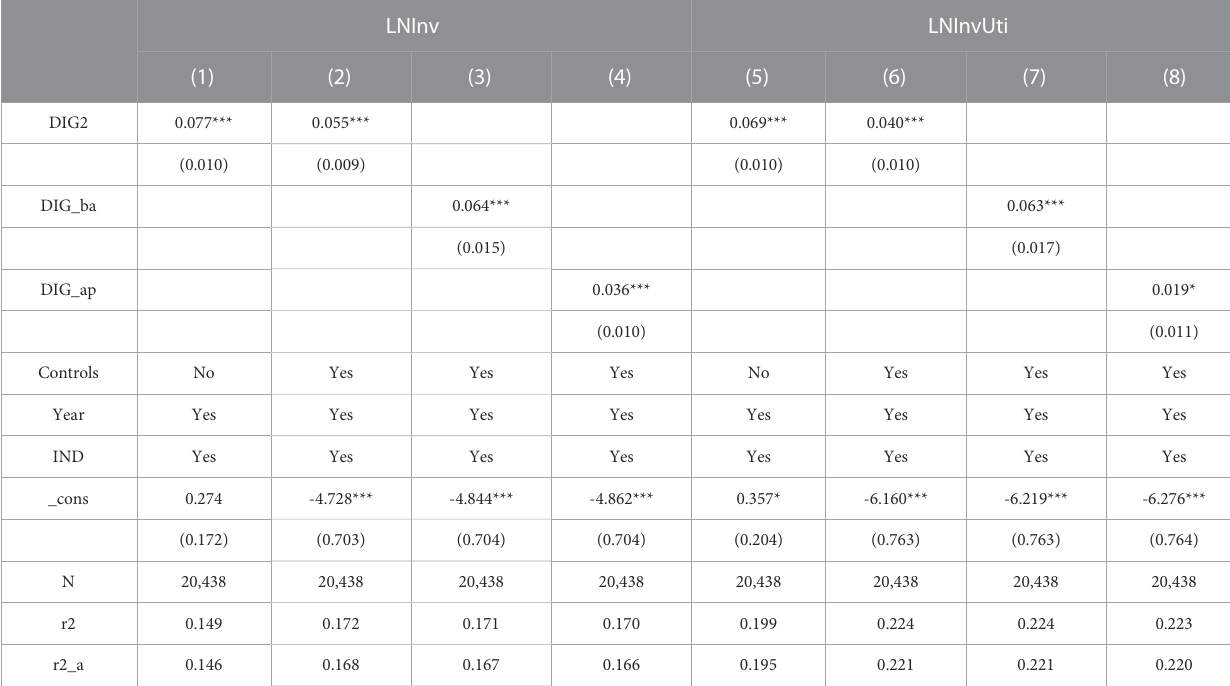
TABLE 8 Test results of re-measurement of independent